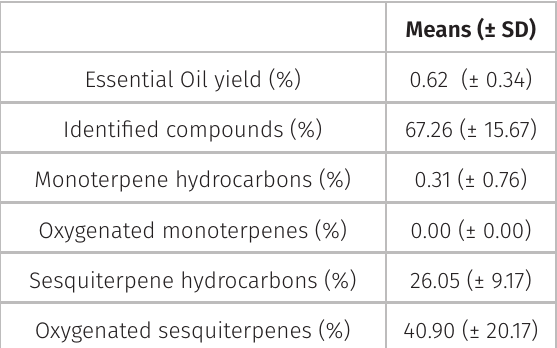
Table I . Essential oil yield, identified compounds, hydrocarbon and oxygenated monoterpenes, and hydrocarbon and oxygenated sesquiterpenes, observed in the analyzed E. uniflora genotypes.